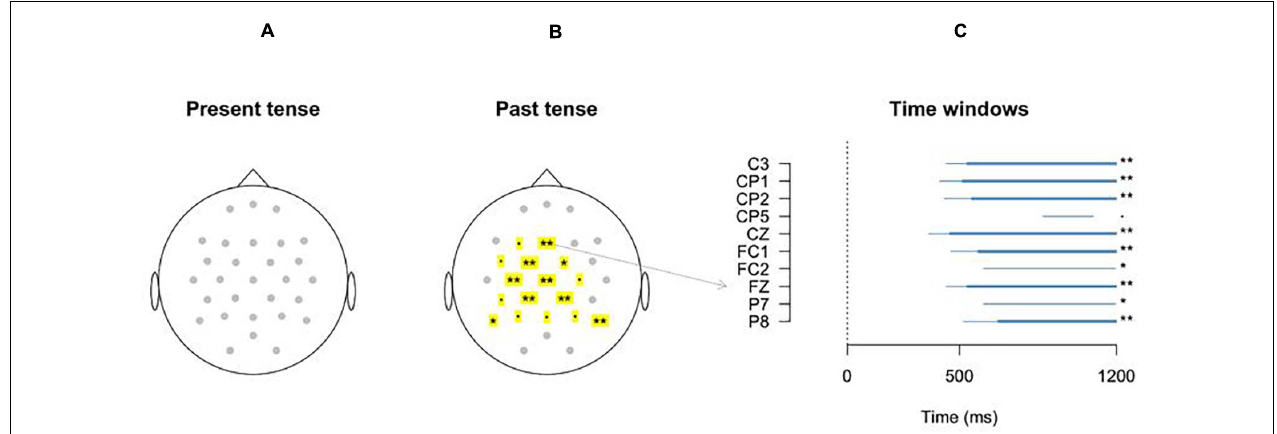
FIGURE 4 | Predicted differences of the GAMM analyses per electrode. (A,B) For the Present tense and Past tense conditions, respectively, the significant differences between grammatical and ungrammatical verbs are indicated with significant stars: *** p < 0.001; ** p < 0.01; * p < 0.05; p < 0.1. Significant differences are only predicted for the Past tense conditions. (C) Represents the time windows in which the GAMM analyses predict the difference to occur. (The thin lines are the estimated differences based on pointwise confidence intervals, whereas the thick lines are the estimated differences based on the simultaneous confidence intervals).